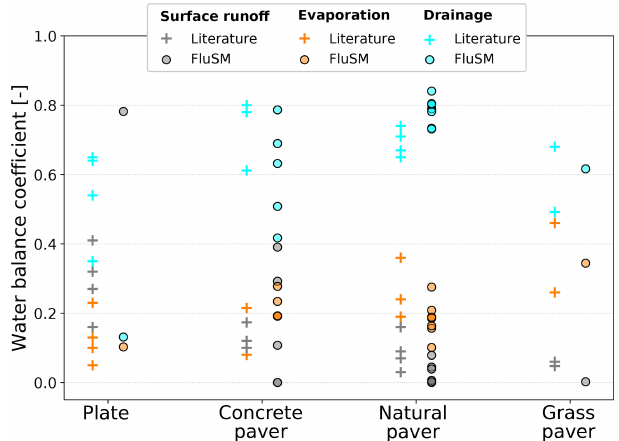
Figure 10. Range of long-term water fluxes reported in the literature for different PP types compared with the results of our case